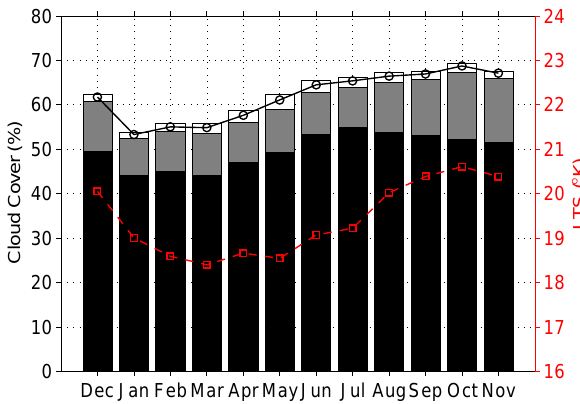
Fig. 2. Seasonal cycles of area-averaged (70 ◦ –110 ◦ W, 10 ◦ –30 ◦ S, refer to box of Fig. 1) ISCCP observed low (black bar), middle (gray bar), high (white bar), adjusted low (solid line with open circle) cloud amount and LTS (dashed line with open